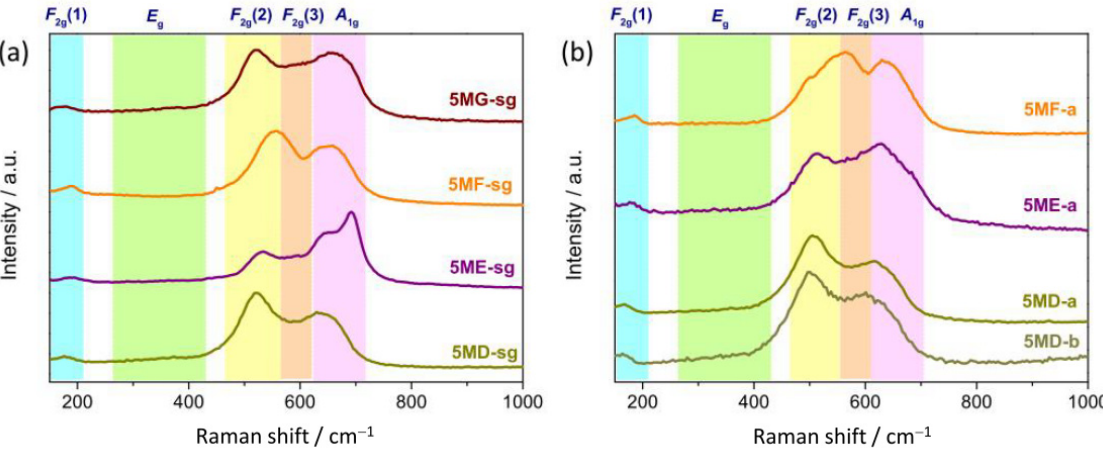
Figure 4. Averaged Raman spectra of pure single-phase HESOs produced via ( a ) sol-gel method and ( b ) electrospinning. The spectrum of sample 5MD-b is also reported.